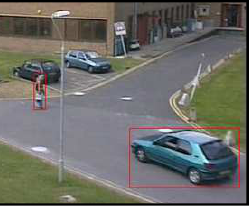
Figure 7 : Rectangle surrounding the object